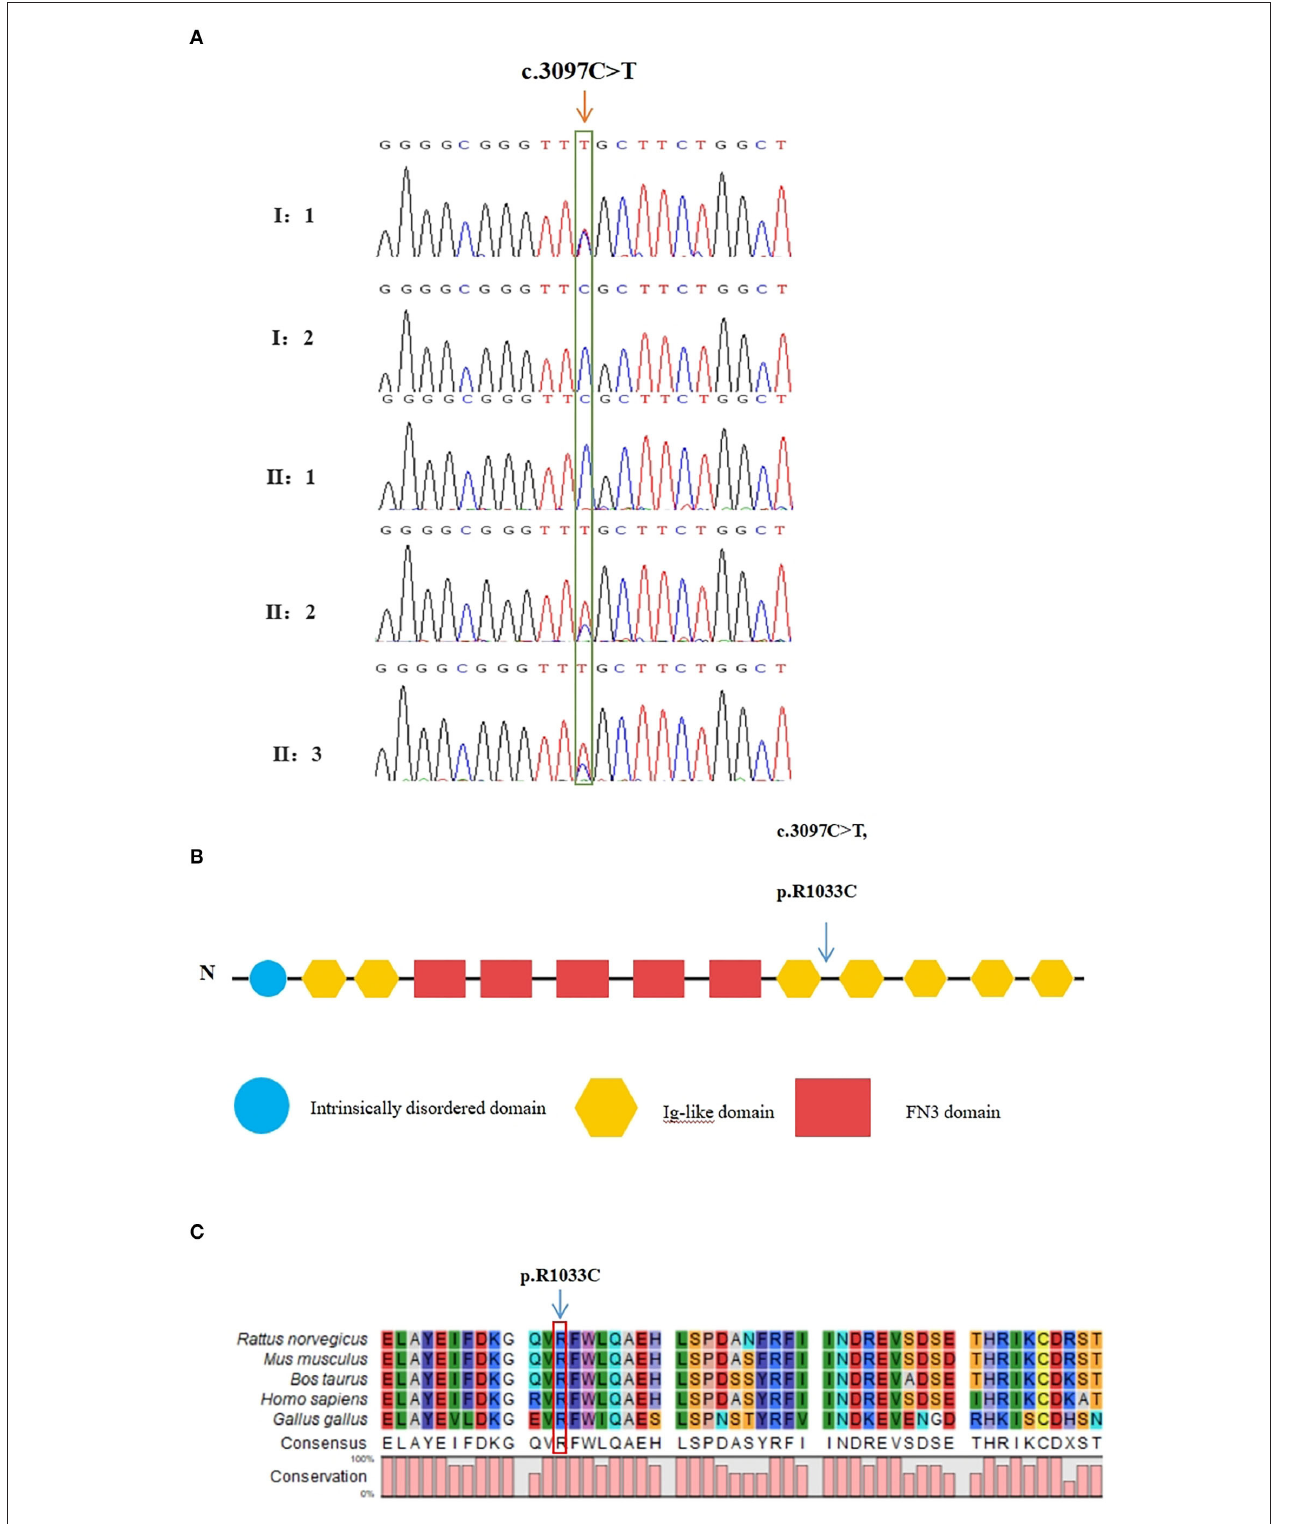
FIGURE 3 | Validation of the missense variant of MYOM2 in the family with TOF. (A) Sanger sequencing results from the probands, their brothers, and their unaffected parents. The heterozygous variant in the MYOM2 gene was identified in the twins, but not in their healthy brother. (B) The location of the variant in the protein structure of MYOM2 . The arrow denotes the mutated site. (C) Amino acid alignment of the MYOM2 protein from several organisms. The position of Arg1033 residue (highlighted by a red box) was highly conserved among different species.